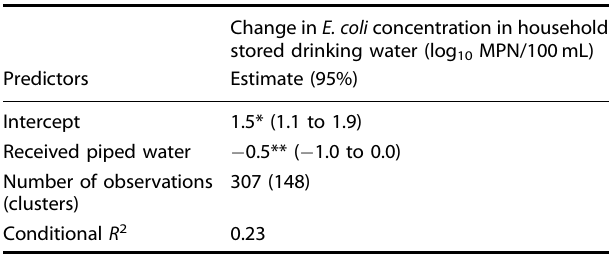
Table 2. Estimated impact of receiving piped water on microbiological contamination of stored drinking water (log 10 Most Probable Number E. coli /100 mL) from multivariate linear mixed effects